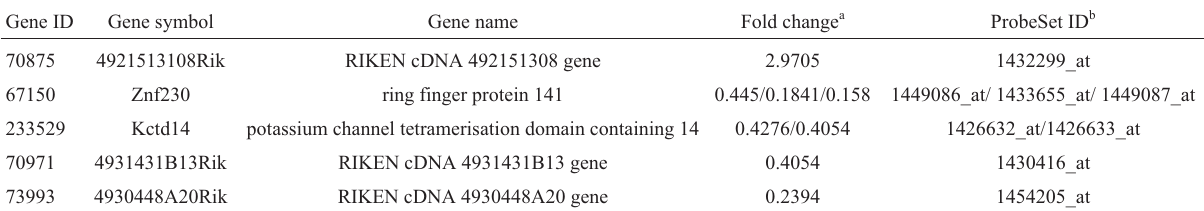
Table 2 - Genes differentially expressed in the testes of Znf230 KO